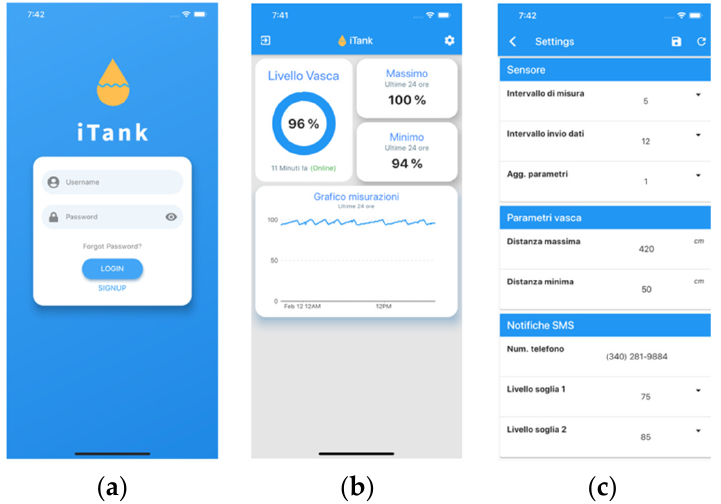
Figure 8. Snapshots from the tank level monitoring app: ( a ) login page; ( b ) tank monitoring info; ( c ) app settings.